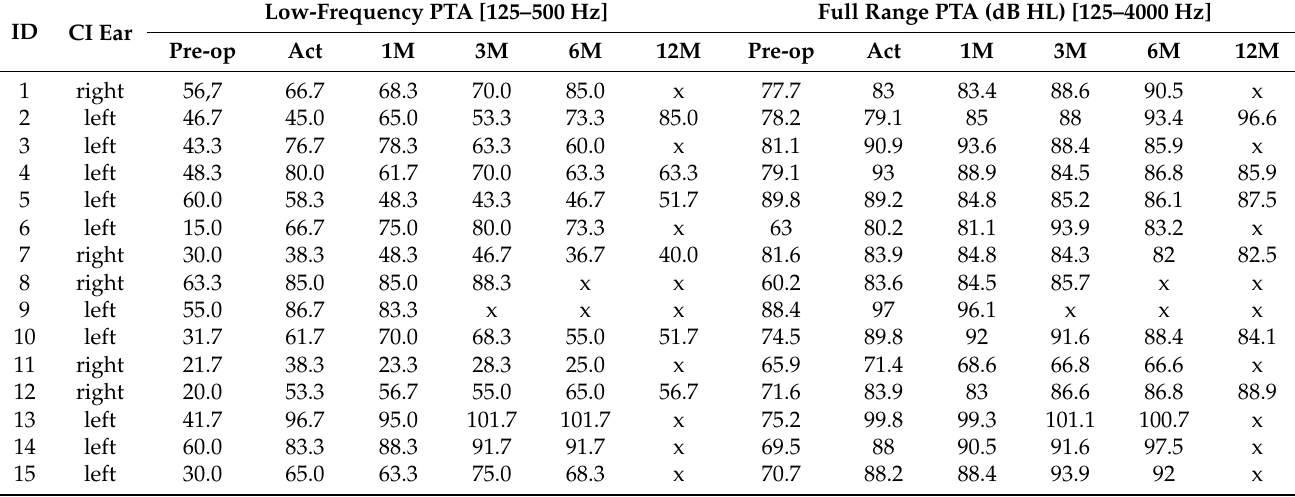
choice of changing the sound processor, and one participant decided to be fitted with the ES and thus left the study (i.e., sample size at the 6M time point N 6m = 13). At the 12M time point, six participants chose to remain with the EAS (i.e., sample size at the 12M time point: N 12mact = 6), while seven participants quit the study due to personal constraints or preference for an ES trial. All collected individual PTAs are presented in Table 2. HP score percentages and classification according to the HEARRING group along with follow-up time points are available in Supplemental Material 1 both for the full range PTAs and PTAs of low-frequency (0.125–500 Hz). Table 2. Individual PTAs for all included participants. ( n = 15). Pre-op = pre-operative visit. Act = activation day visit. 1M, 3M, 6M and 12M refer, respectively, to one-month, three-month, six-month and twelve-month visits after activation. x refers to participants out of study. PTA = pure-tone audiometry; HL = hearing